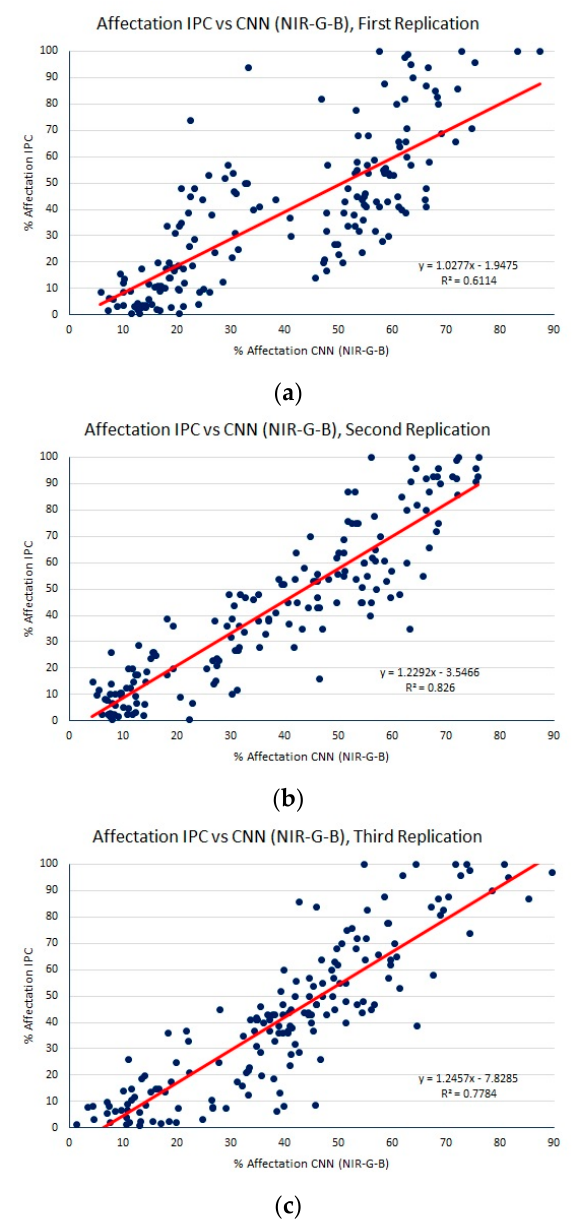
Figure 11. Percentage of P. infestans affectation using IPC methodology vs. estimated percentage of affectation using CNNs on the NIR-G-B multispectral dataset, for ( a ) first replication, MAE: 13.56, RMSE: 17.10, R 2 : 0.6114; ( b ) second replication, MAE: 10.83, RMSE: 13.93, R 2 : 0.8260; ( c ) third replication, MAE: 10.83, RMSE: 13.93, R 2 : 0.8260. CNN: convolutional neural networks. Table 1. Summary of Regression Results.